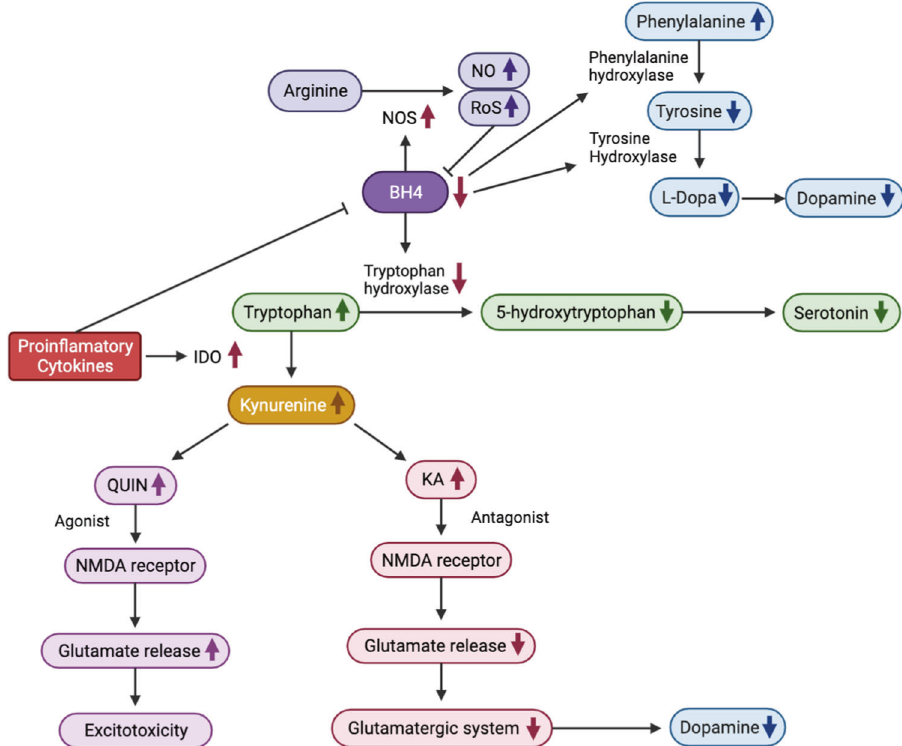
Fig. 4 Pro-in fl ammatory cytokine-induced changes in neurotransmitter systems. Mechanisms by which proin fl ammatory cytokines affect the synthesis of monoamine neurotransmitters (i.e., serotonin and dopamine) are illustrated. BH4 tetrahydrobiopterin, IDO indoleamine 2,3- dioxygenase, KA kynurenic acid, NMDA N-methyl- D -aspartate, NO nitric oxide, NOS nitric oxide synthases, QUIN quinolinic acid, ROS reactive oxygen